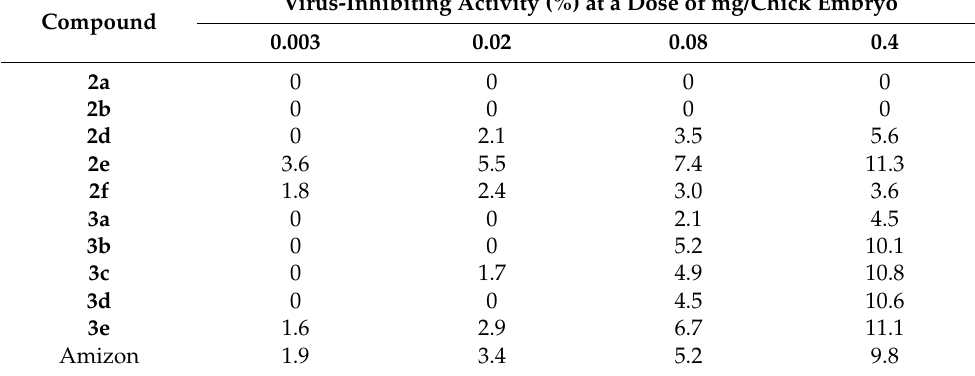
Table 1. Virus-inhibiting activity of the test compounds when exposed to a strain of human influenza virus A/Almaty/8/98 (H3N2).